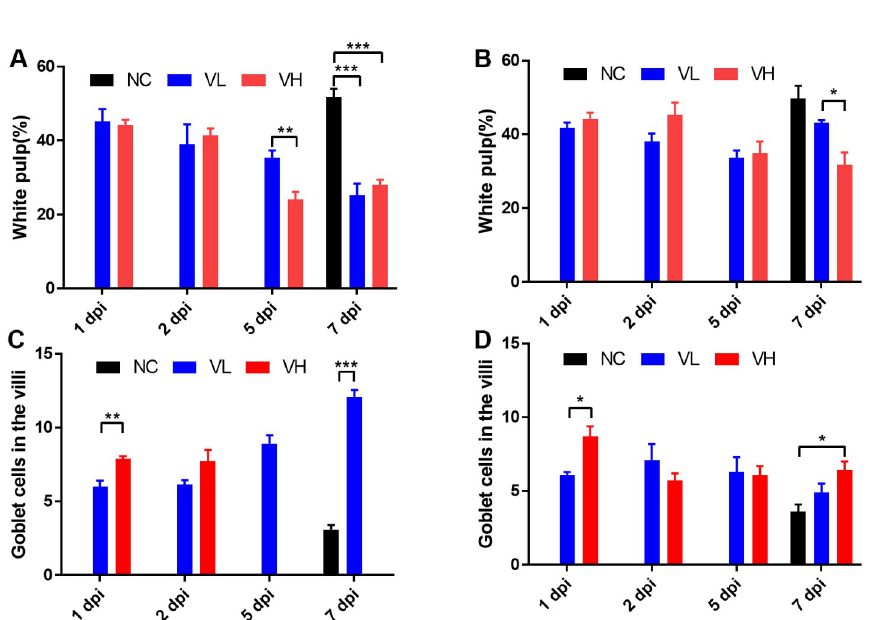
Fig 8. Histopathological scoring of spleens and small intestines of SARS-CoV-2 infected K18-hACE2 and CAG- hACE2 transgenic mice. Atrophy of white pulp was calculated as the area of white pulp relative to a total area of the spleen. The small intestine of each group was scored as indicated in Table 2. (A) Area of white pulp of K18-hACE2 mice; (B) Area of white pulp of CAG-hACE2 mice; (C) Number of goblet cell in small intestine of K18-hACE2 mice; (D) Number of goblet cell in small intestine of K18-hACE2 mice. Data is represented as mean ± SE at indicated day post-infection (dpi). The VH group of K18-hACE2 transgenic mice died at 6 dpi, marked as 7 dpi. � P < 0.05; �� P < 0.01; ��� P < 0.001 as assessed using unpaired two-tailed t-test.